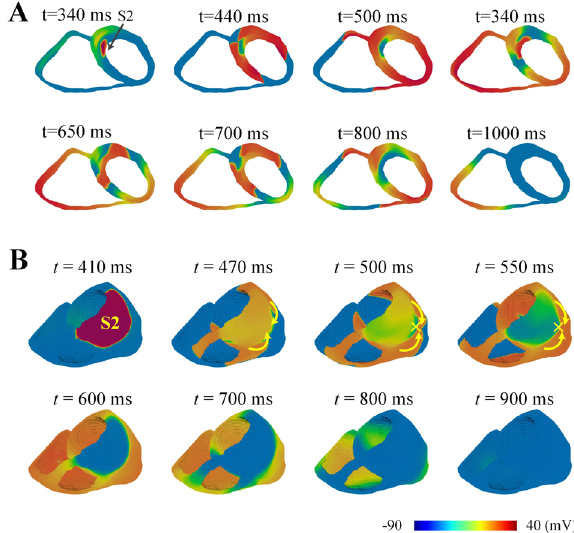
Fig. 10 Simulation results of the reentry arrhythmias in the condition of quinidine. A Spiral waves on the 2D ventricular slice. Spiral waves were evoked by the S1 – S2 protocol, and the black arrow indicates the stimulating location of S2. Quinidine prevented the persistent arrhythmias, which was evidenced by the disappear- ance of spiral waves at about 1000 ms. B Scroll waves in the 3D ventricle. In line with the 2D simulation results, the evoked scroll waves were not sustainable and disappeared at about 900